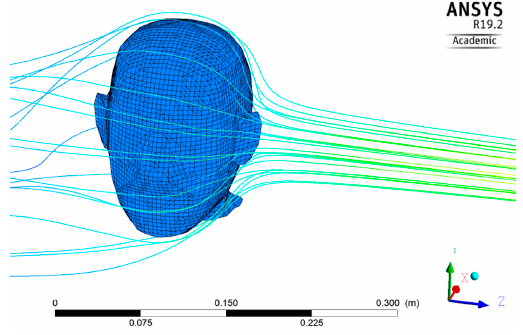
Figure 7. Streamlines around the head.